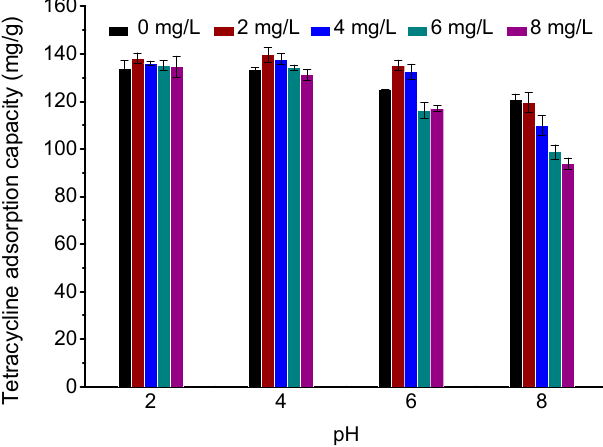
Figure 5. Effects of different humic acid concentration (2, 4, 6, and 8 mg/L) on TC adsorption onto Fe 3 O 4 @GO under various pH (pH = 2, 4, 6, and 8), m / V = 70 g/L, C 0(TC) = 10 mg/L, T = 303 K, t = 24 h.